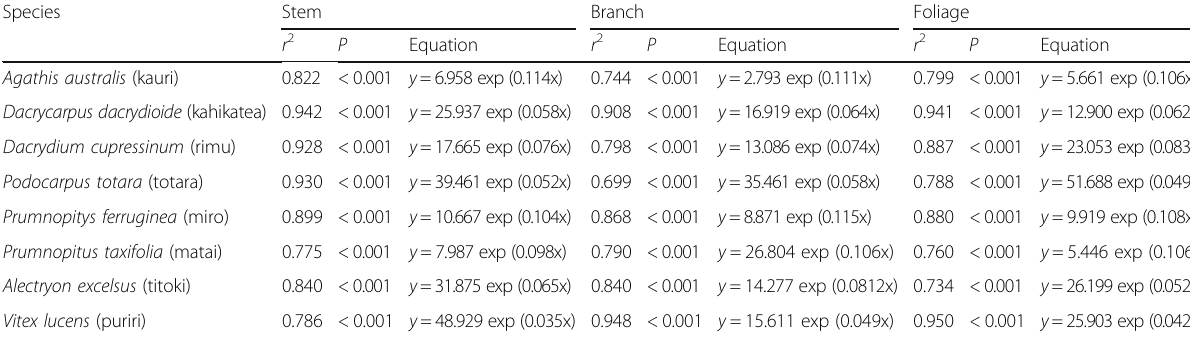
Table 2 Allometric relationships between RCD against stem, branch and foliage